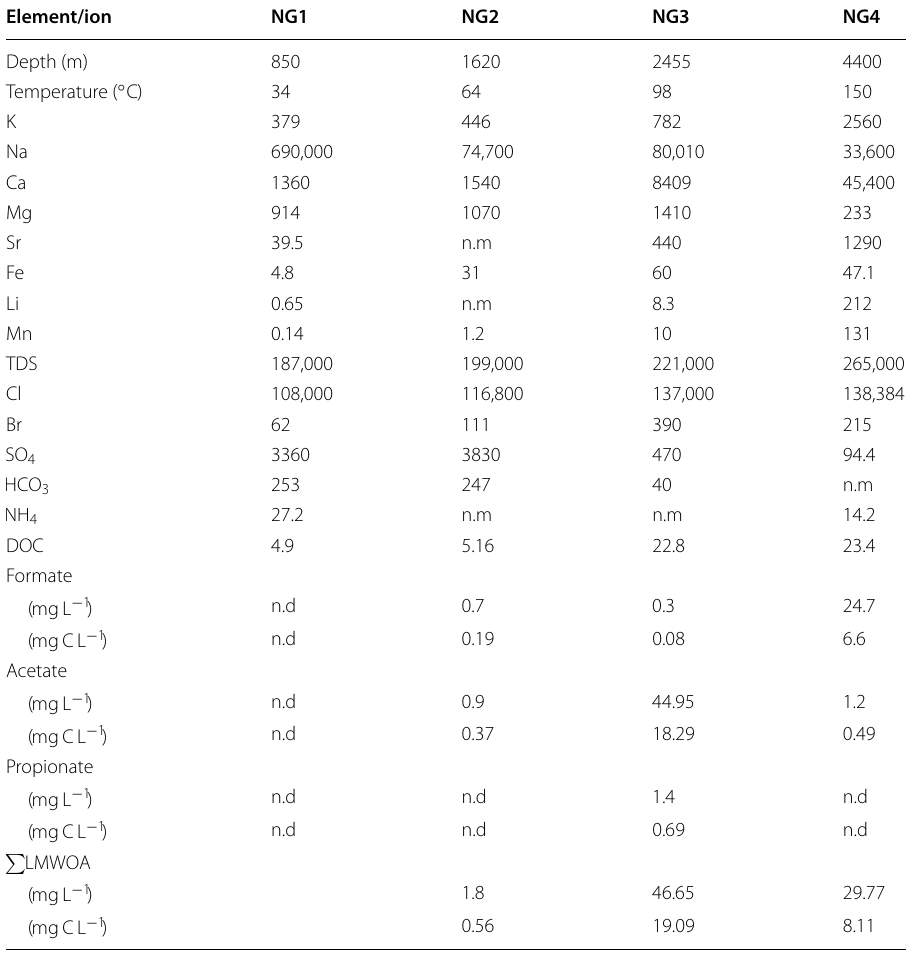
Table 4 Organic and inorganic fluid chemistry of NGB sites ( mgL − 1